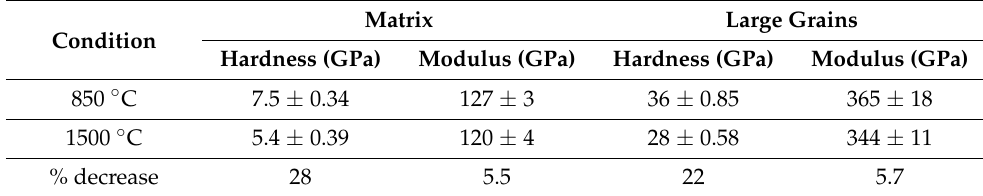
Table 1. Nanoindentation data from 850 ◦ C and 1500 ◦ C